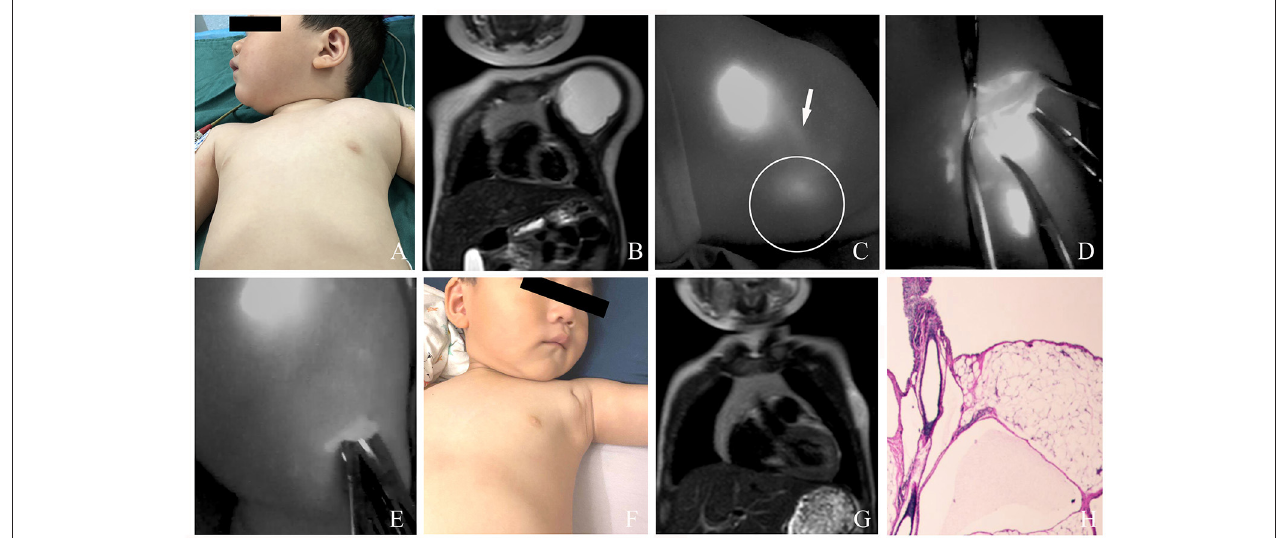
FIGURE 5 | (A) A 2-year-old male patient with macro cLM of the left chest preoperatively. (B) MRI preoperatively. (C) ICG finding with one afferent lymph vessel draining into a lesion. (D) The cLM lesion confirmed by ICG lymphography during surgery. (E) No inflow visualization or lymphatic leak on the previous detected site after inflow occlusion. (F) Ten months postoperatively, complete regression of cLM met the criterion of excellent curative effect. (G) MRI postoperatively. (H) Pathology postoperatively. Arrow head , lymph vessel; circle , region of cLM.